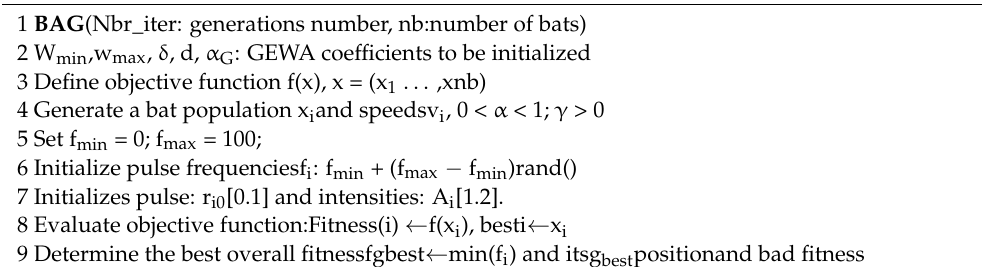
Algorithm 1 : Hybridization of the GEWA and BAT in the BAG